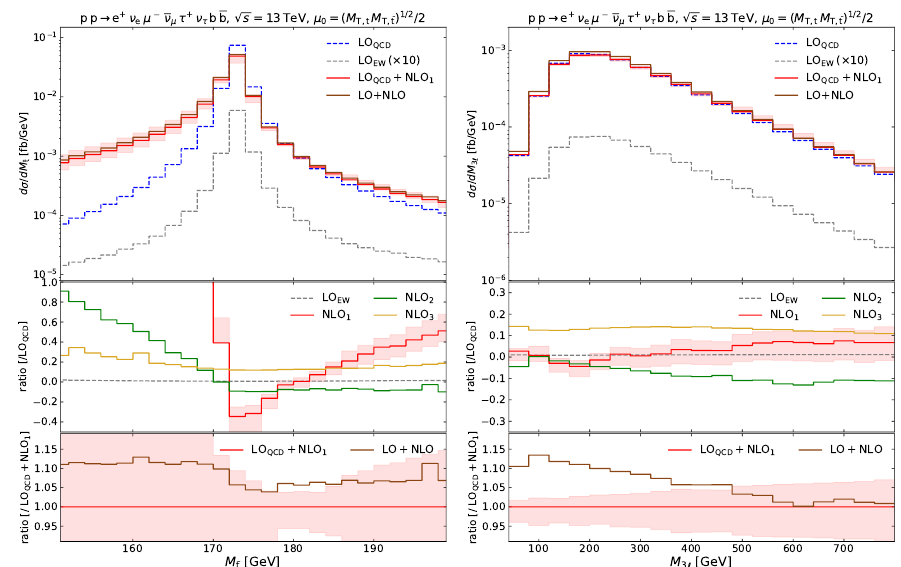
Figure 6: Distributions in the invariant mass of the antitop quark (left) and of the three-charged-lepton system (right). Same structure as Fig.